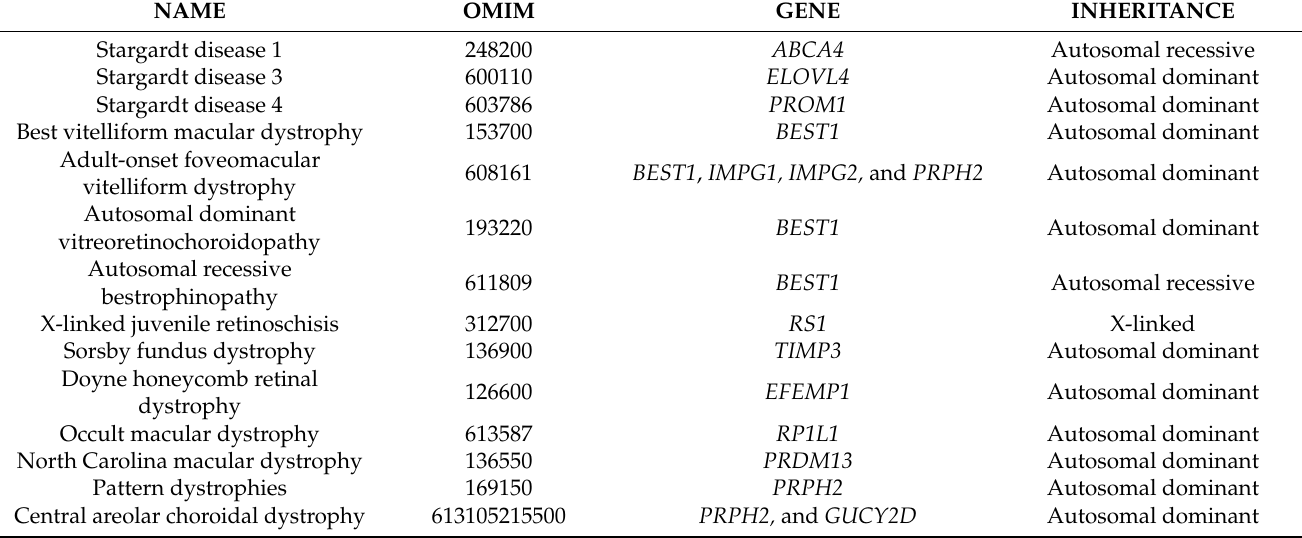
Table 1. Genetic information of the macular dystrophies reviewed in this